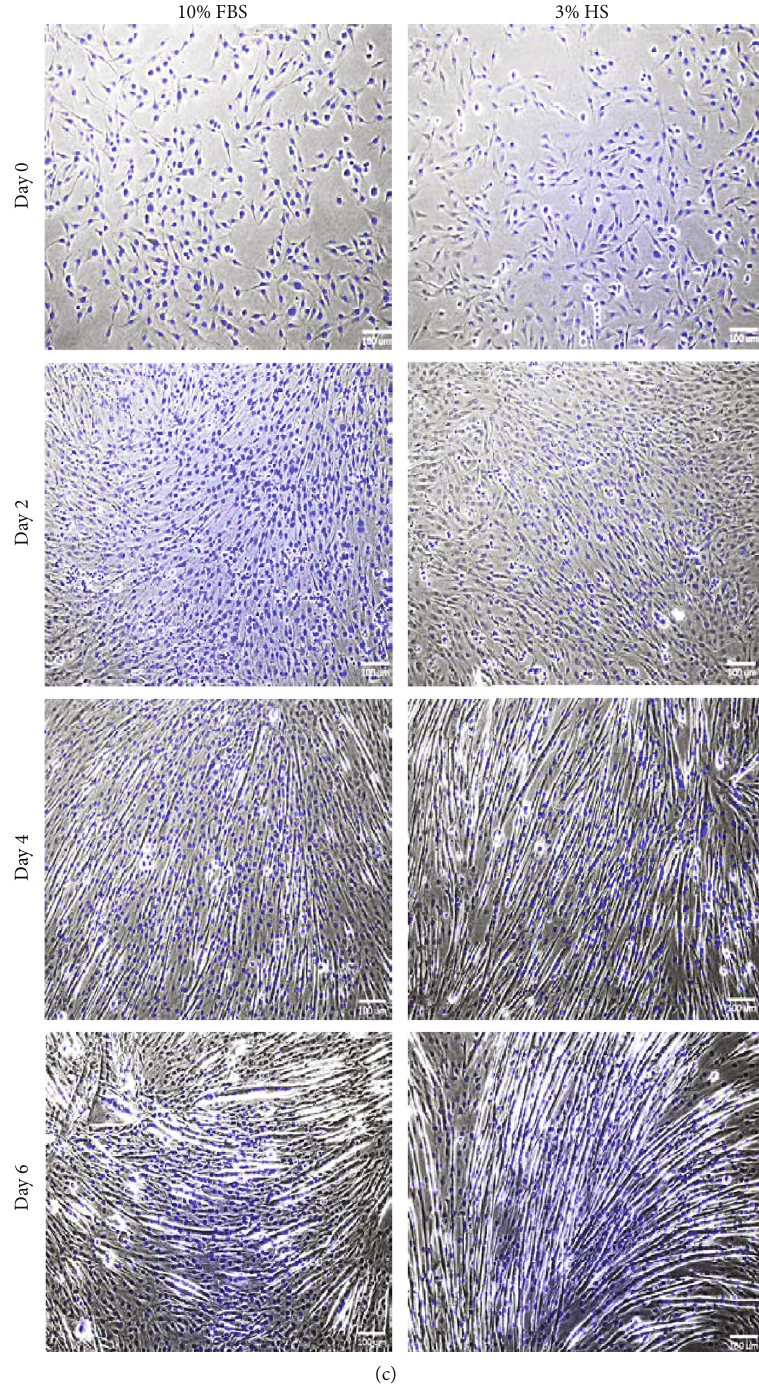
Figure 1: C2C12 myogenic di ff erentiation. Expression of MURC, myogenin and MyHC mRNA (a) and protein (b) from C2C12 cells at the time indicated during myogenesis in media containing either 10% fetal bovine serum (FBS) or 3% horse serum (HS) was examined (n =3). ∗ p < 0 : 05 and ∗∗ p < 0 : 01 v.s 10% FBS at day 0, # p < 0.05 v.s 3% HS at day 0, ∫ p < 0.05 v.s 10% FBS group at the same day. (c) Morphology of cells at the indicated day was stained with DAPI and examined by fl uorescence